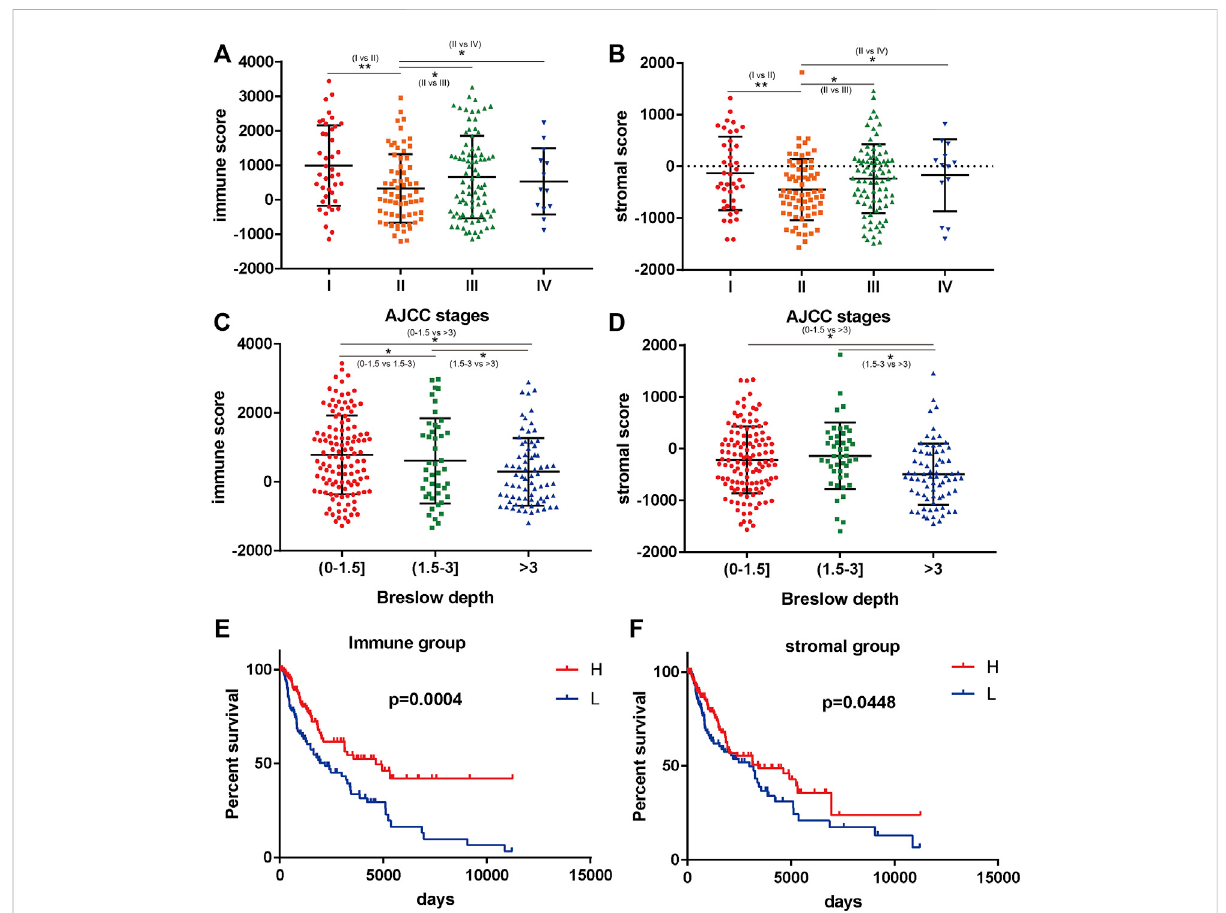
FIGURE 1 Immune scores and stromal scores are closely associated with BRAF mutated melanoma prognosis. (A , B) the correlation between immune/ stromal score and AJCC stage. (C , D) the correlation between immune/stromal score and Breslow depth. (E , F) high immune scores and stromal scores were associated with longer survival ( p < 0.05). * p < 0.05; ** p < 0.01; *** p <